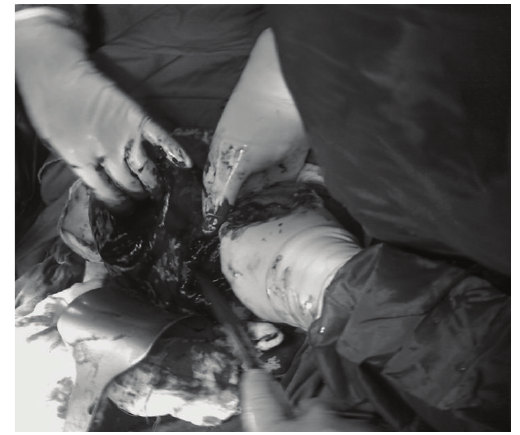
Figure 3: Two incisions were repaired